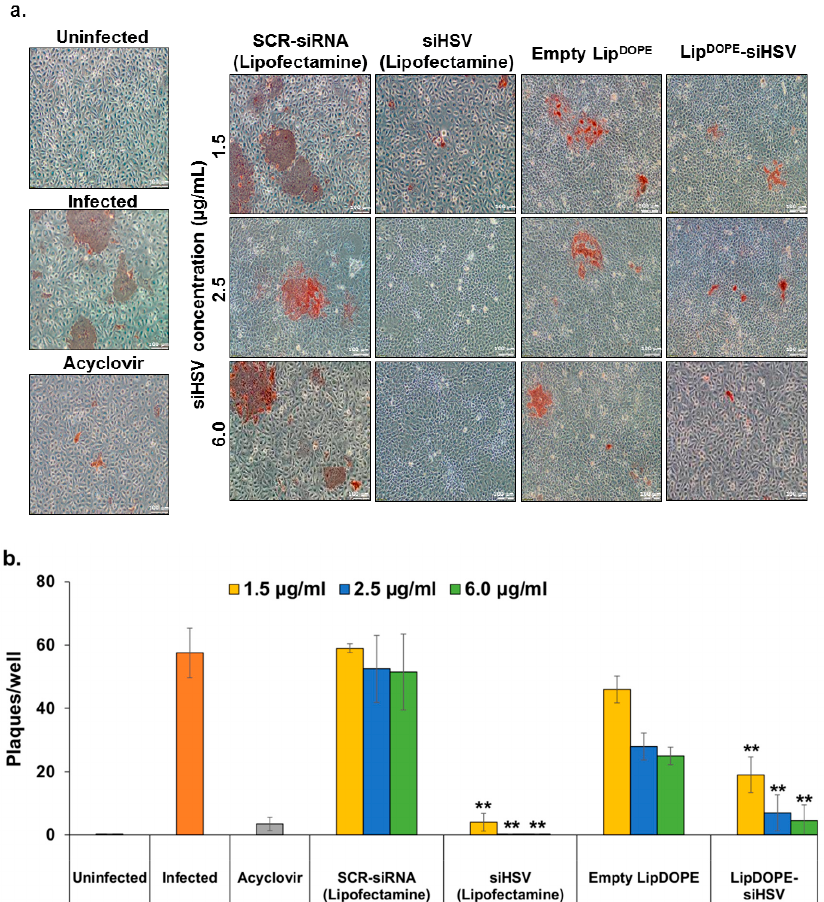
Figure 7. The antiviral effect of Lip DOPE -siHSV following treatment of HaCaT cells (keratinocytes) infected with HSV-1 (plaque reduction assay). ( a ) Treatment groups: Lip DOPE -siHSV, empty Lip DOPE and scrambled-siRNA (SCR-siRNA transfected by lipofectamine) served as negative controls, and acyclovir (125 µ M) and siHSV (transfected by lipofectamine) served as positive controls, in comparison to uninfected cells and untreated infected cells. Following 48 h of treatment, the cells were infected with HSV-1 (1 × 10 4 PFU) for 16 h. The formed syncytia, shown in brownish red, was visualized following immunohistochemistry staining of the cells (anti-HSV1 antibody; n = 8). Brownish red staining depicts the envelope-protein of the virus, indicating proliferative infection, and no staining indicates full protection (magnification ×10; scale bar = 100 µm). ( b ) Semi-quantitative analysis of the antiviral efficacy (** p < 0.01).